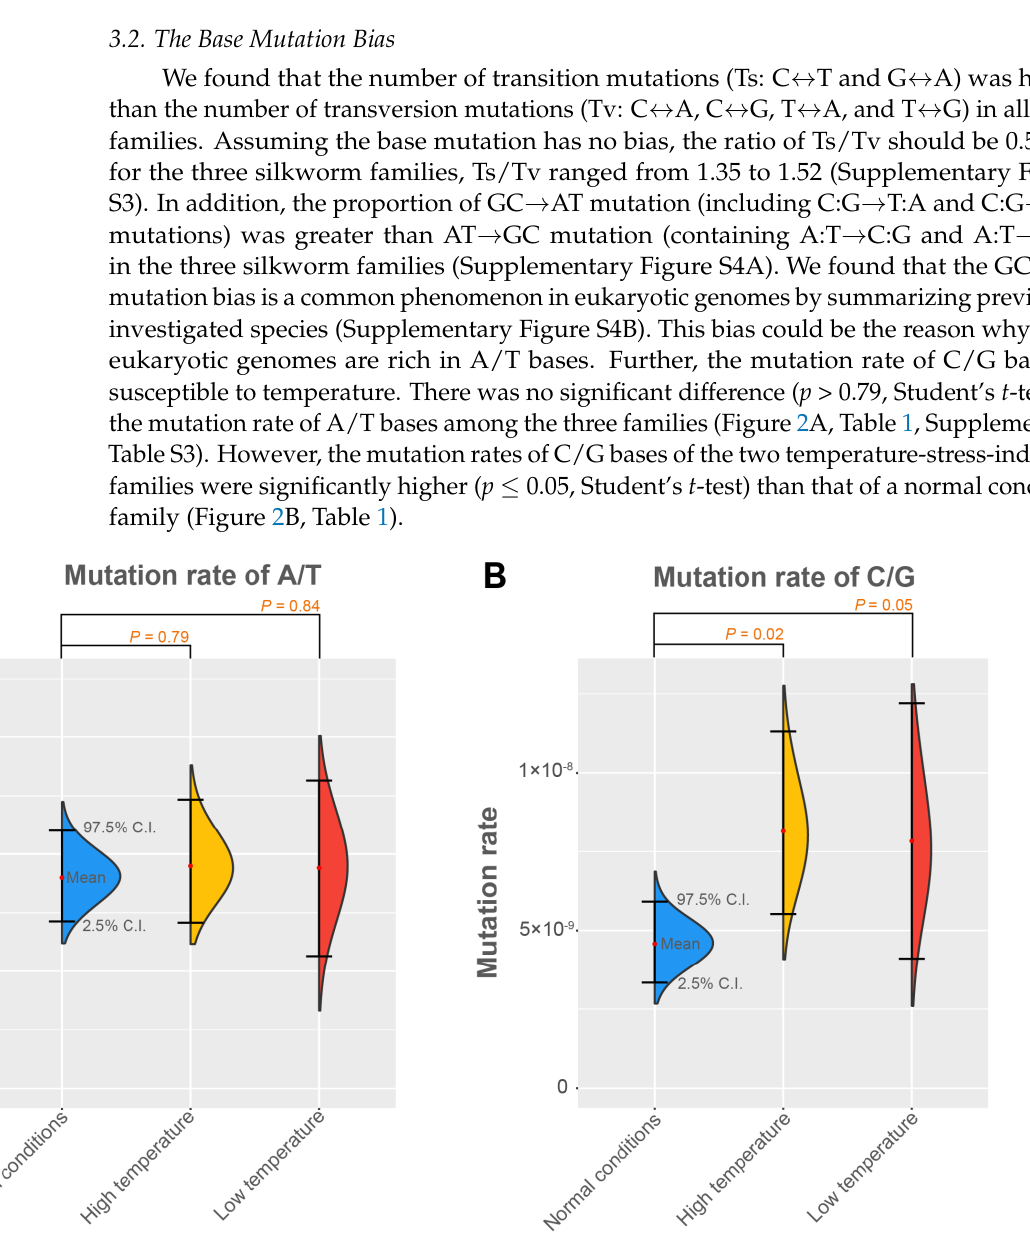
Figure 2. Mutation rates of A/T bases and C/G bases of the silkworm under different conditions. The mean value and 95% confidence intervals of the mutation rate of ( A ) the A/T bases and ( B ) the C/G bases. The 95% confidence interval of the mutation rate was estimated using bootstrap method with 1000 bootstrap estimates. Student’s t -test was used to test differences in the mutation rate (observed mutation rate per genome) between each stress-inducing family and normal condition